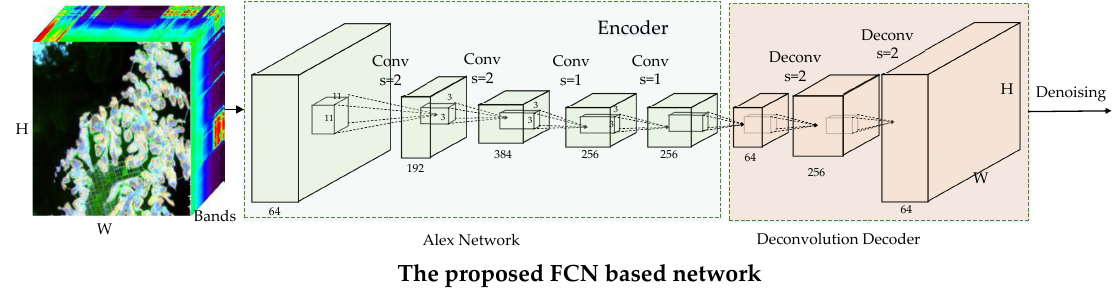
Figure 2. Architecture of the proposed FCN-based